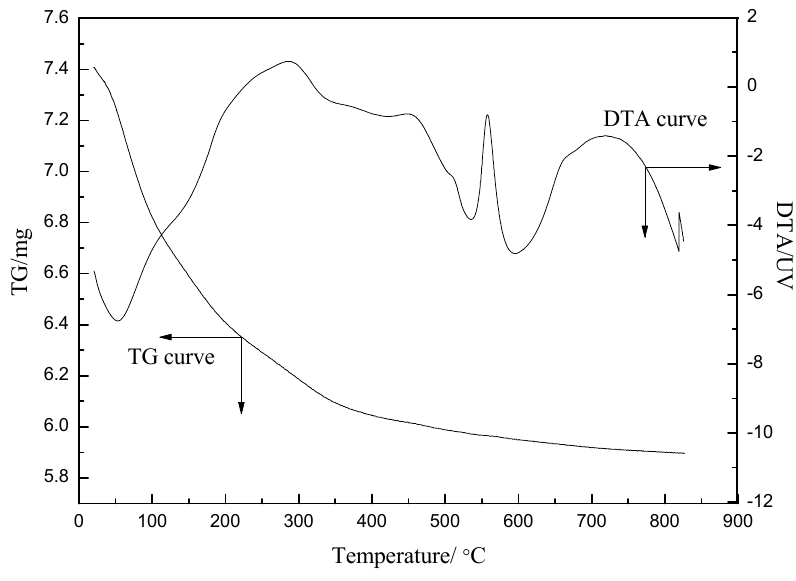
Figure 7. TG-DTA curves of the Pt/WZ precursor catalyst.